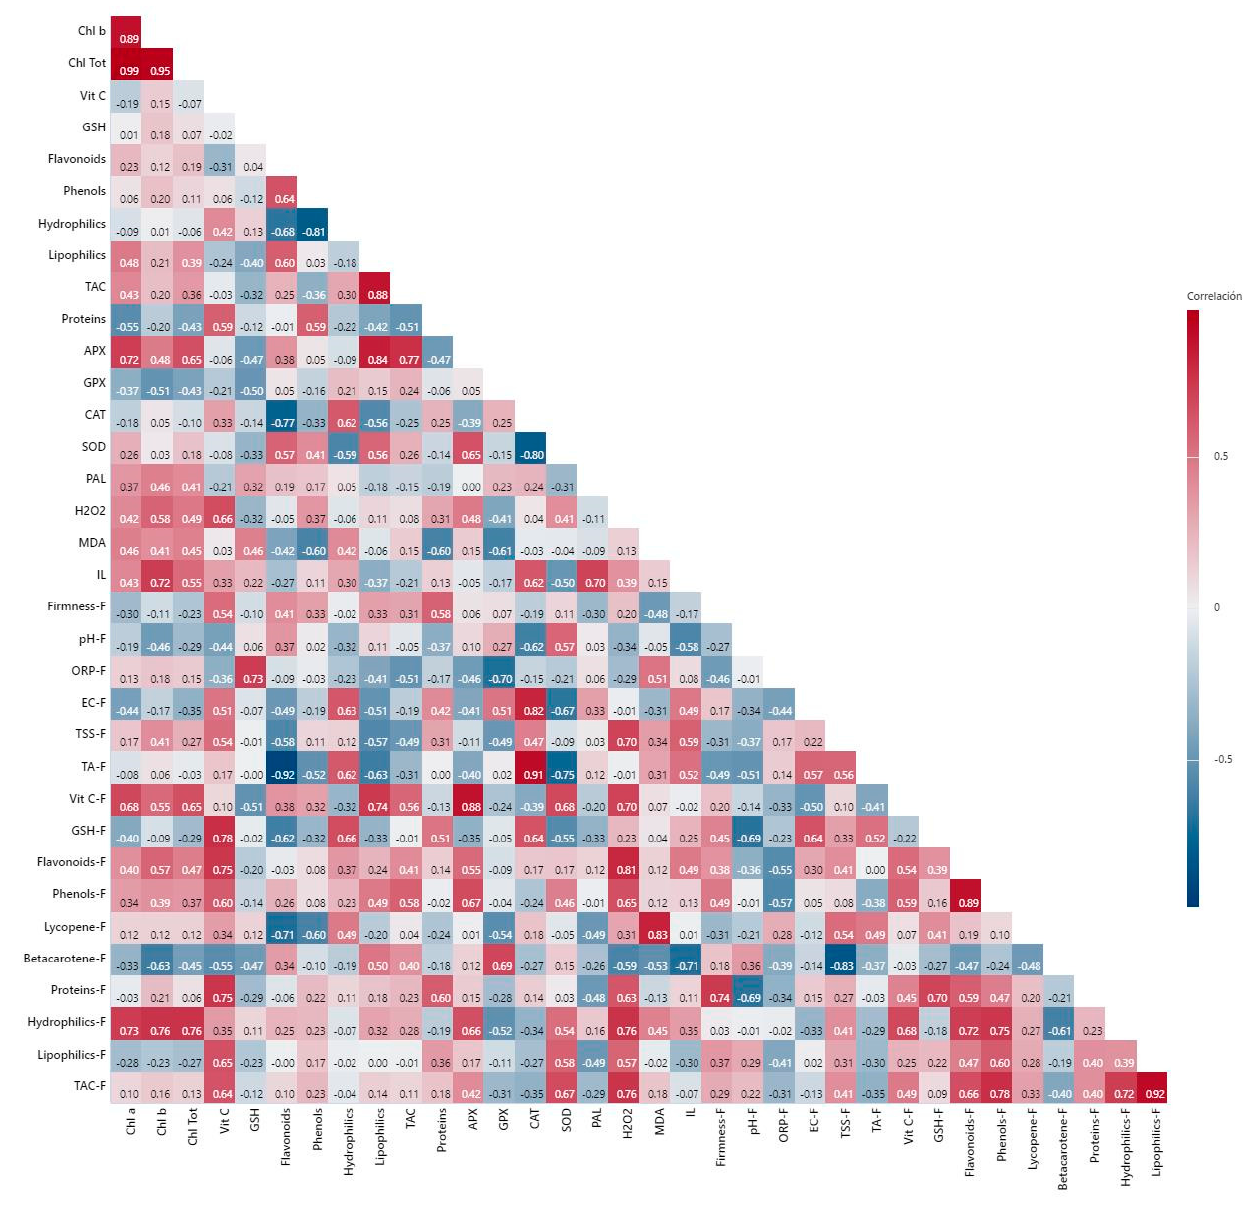
Figure 9. Pearson’s correlation of all variables obtained from stressed plants. Chl a: chlorophyll a; Chl b: chlorophyll b; Chl Tot: total chlorophylls; Vit C: vitamin C; GSH: glutathione; Hydrophilics: hydrophilic antioxidant capacity; Lipophilics: lipophilic antioxidant capacity; TAC: total antioxidant capacity; APX: ascorbate peroxidase; GPX: glutathione peroxidase; CAT: catalase; SOD: superoxide dismutase; PAL: phenylalanine ammonia lyase; MDA: malondialdehyde; IL: ion leakage; ORP: oxidation reduction potential; EC: electrical conductivity; TSS: total soluble solids; TA: titratable acidity. The “F” in front of each word represents each variable determined in